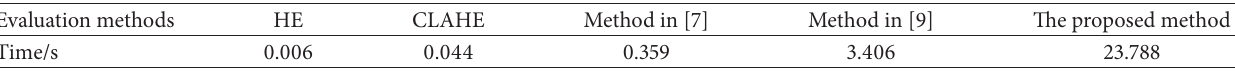
Table 5: The average running time comparison of different methods on the STARE database (including 20 images). Evaluation